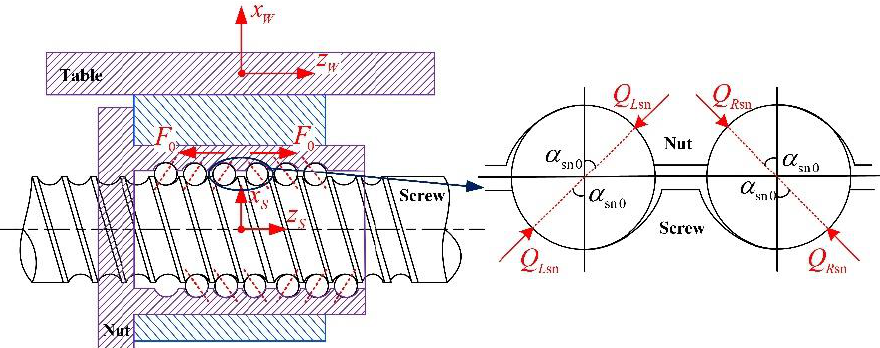
Figure 3. Structure of a single nut ball screw under preload.